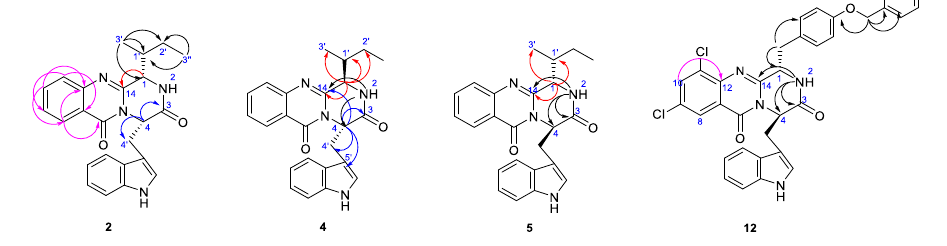
Figure 2. Key HMBC correlations for 2 , 4 , 5 , and 12 .